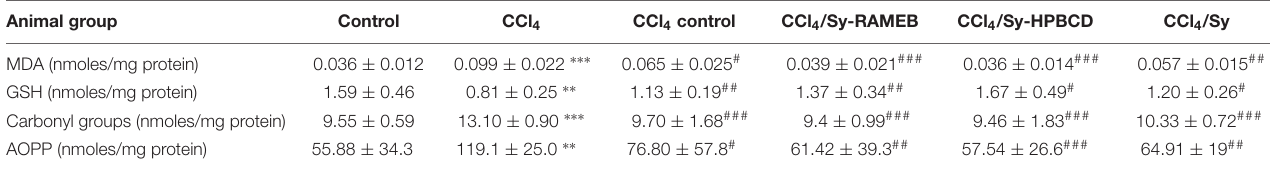
TABLE 3 | The values of MDA, GSH, carbonyl groups, and AOPP concentrations after the treatment with CCl 4 and various forms of silymarin Animal